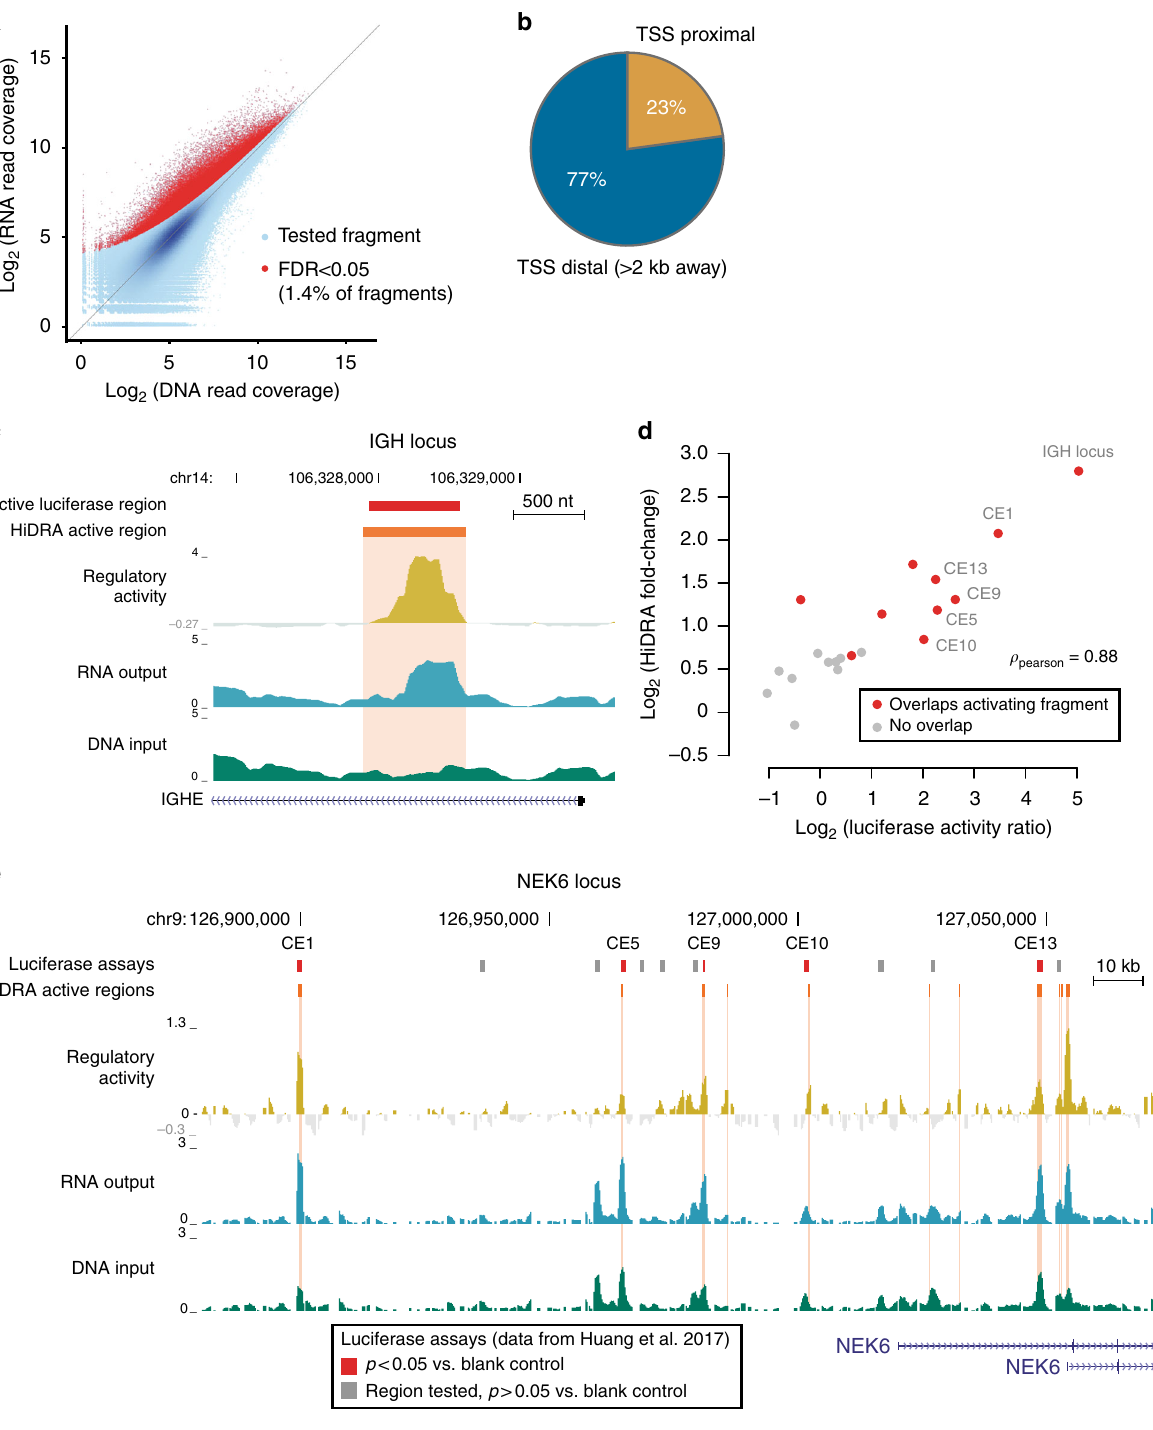
Fig. 2 HiDRA identi fi es transcriptional regulatory elements. a Scatterplot of abundances for HiDRA fragments in input (plasmid DNA) and output (RNA) samples. Abundances calculated after merging all fi ve replicates. Active HiDRA fragments called by DESeq2 highlighted with red dots (FDR < 0.05), blue color intensity corresponds to greater density of points. b The majority of HiDRA active regions are distal to annotated TSSs ( > 2 kb). c HiDRA identi fi es enhancer activity within an intron in the immunoglobulin heavy chain locus. Red bar, DNA segment active in luciferase assay performed by Huang et al. 23 . Orange bar and highlight, region identi fi ed by HiDRA as having transcriptional regulatory activity. d Quantitative comparison of luciferase assay activity levels to HiDRA for 21 predicted enhancer elements. HiDRA signal corresponds to maximum activity within the region tested by luciferase, and luciferase value corresponds to median normalized activity over biological replicates. Pearson correlation calculated after log2 transformation. e Comparison of HiDRA-called active regions with luciferase assay results for 13 enhancers at the NEK6 locus. Luciferase experiments are colored in red or gray depending on whether DNA fragments drive luciferase activity in GM12878 cells as determined by Huang et al.